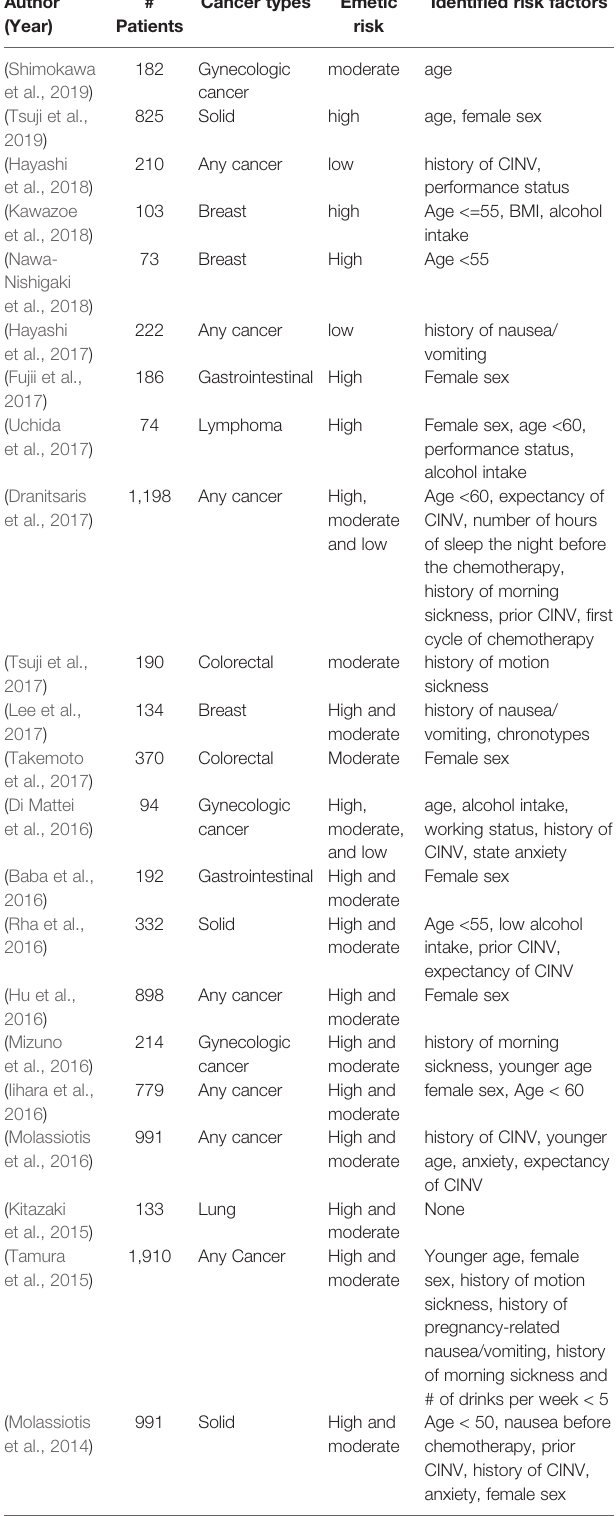
TABLE 2 | Patient-related risk factors of Chemotherapy-Induced Nausea and Vomiting